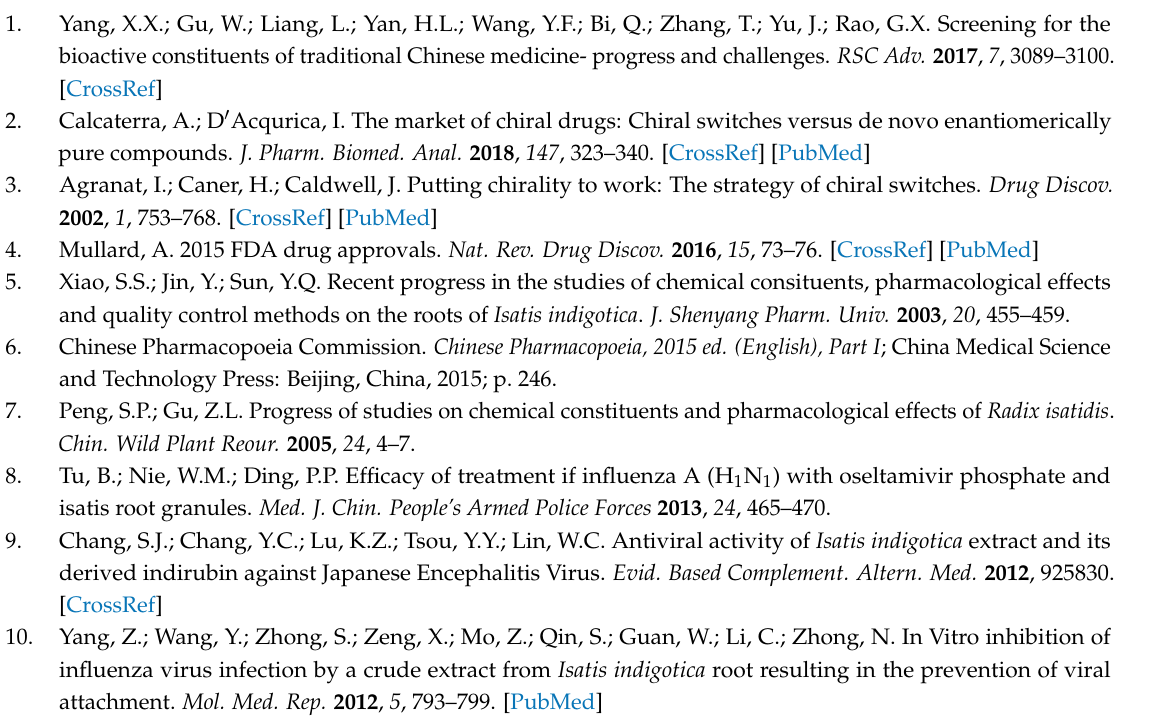
Supplementary Materials: The following are available online. Figure S1: The CD absorbance features of R - and S -goitrin (A), maximum UV absorbance spectrum of the four glucosinolates (B), and the chemical profiling of the four glucosinolates in five different wavelength (C); Table S1: Crude drugs, decoction pieces and granules of Radix Isatidis used in this study; Table S2: The contents of four glucosinolates in 37 samples from crude drugs, decoction pieces and granules of Radix Isatidis ( n =